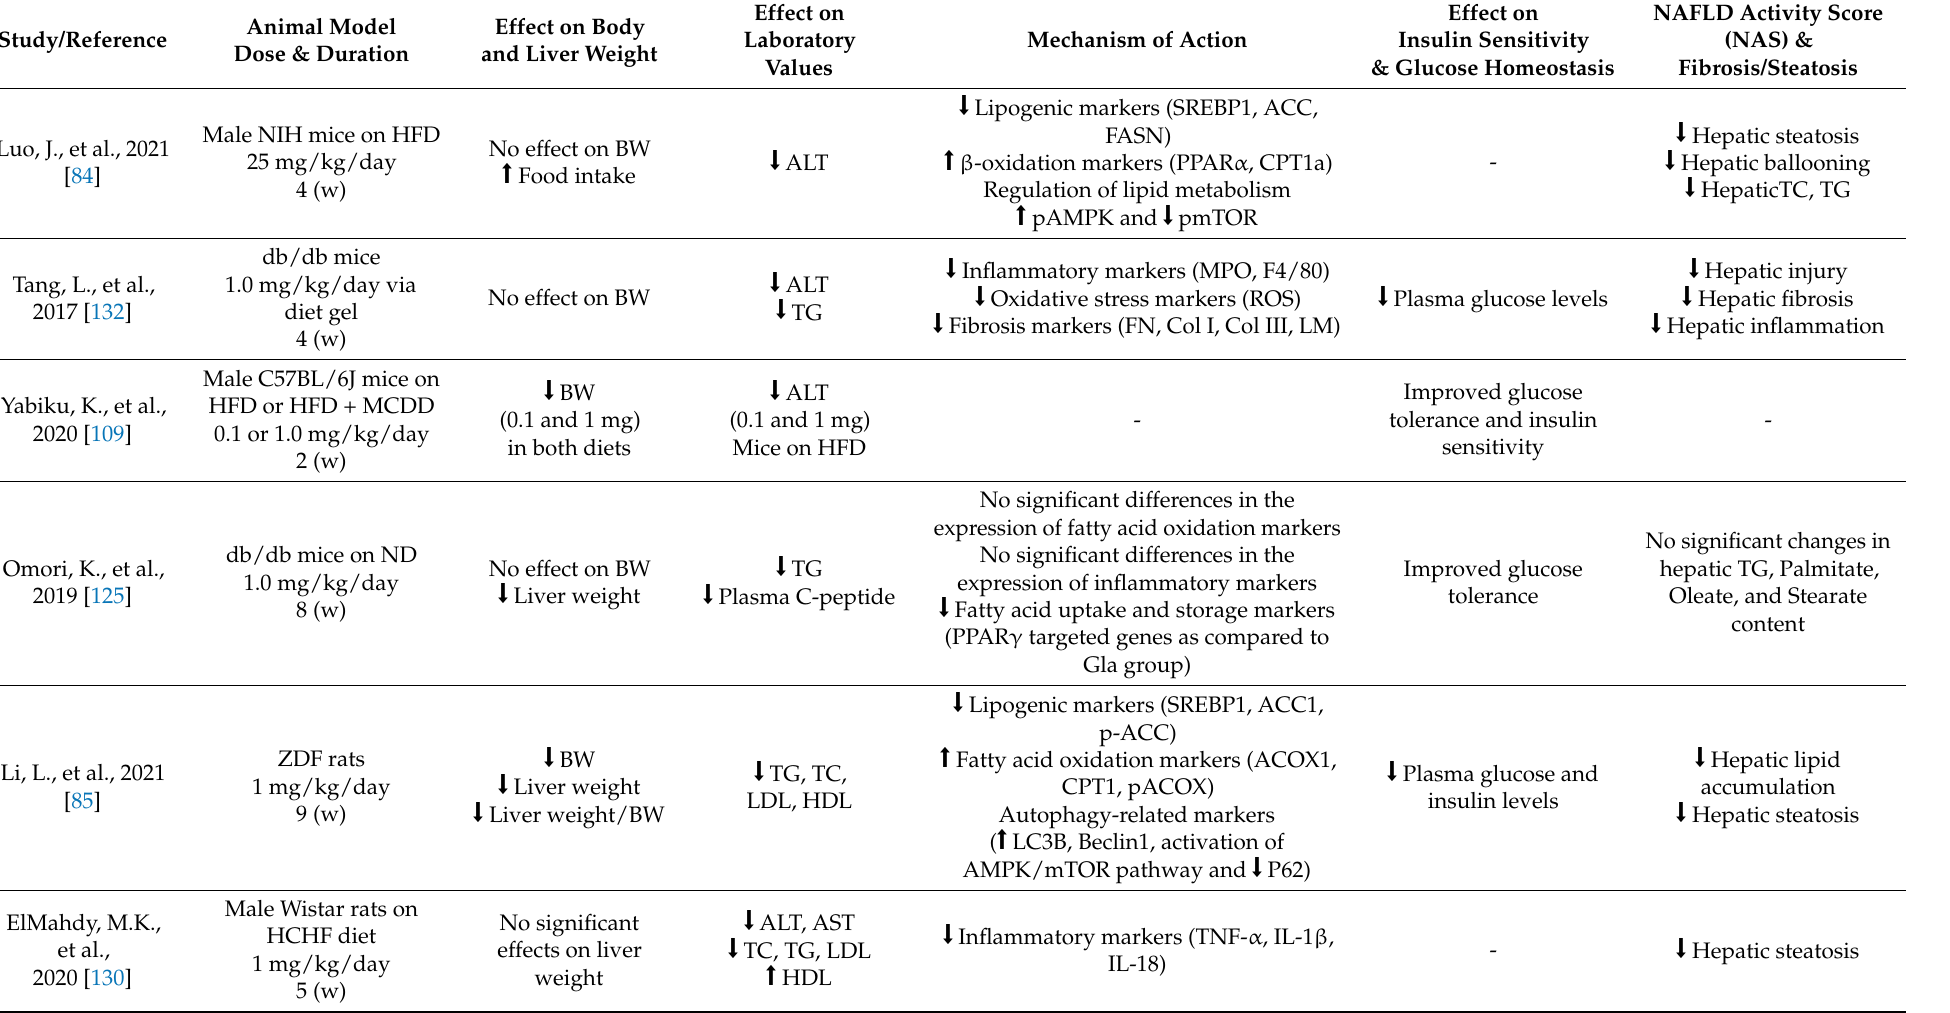
Table 1. Key animal studies regarding the impact of empagliflozin on NAFLD/NASH.